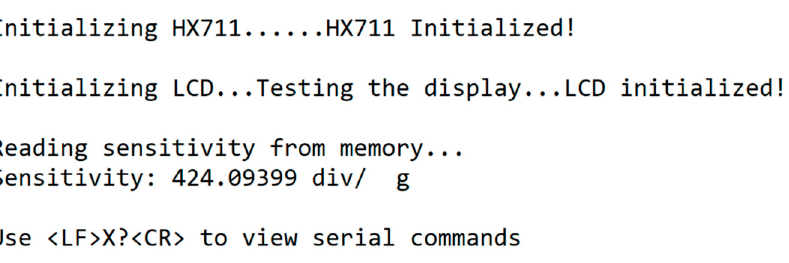
Figure 9. The scale returns a readout similar to the one shown during initialization. The readout indicates the action in progress, success, and returns the sensitivity value when reading from memory.